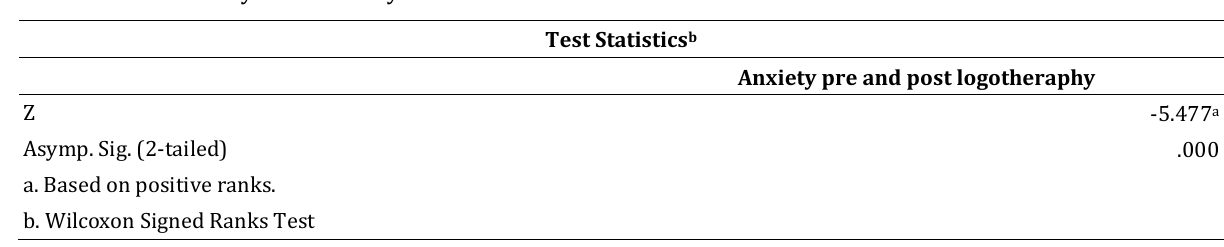
Table 6. Results of data output Effects of Paradoxical Intention Session 1 Logotherapy on Prisoners Anxiety in Class II A Penitentiary in Kediri